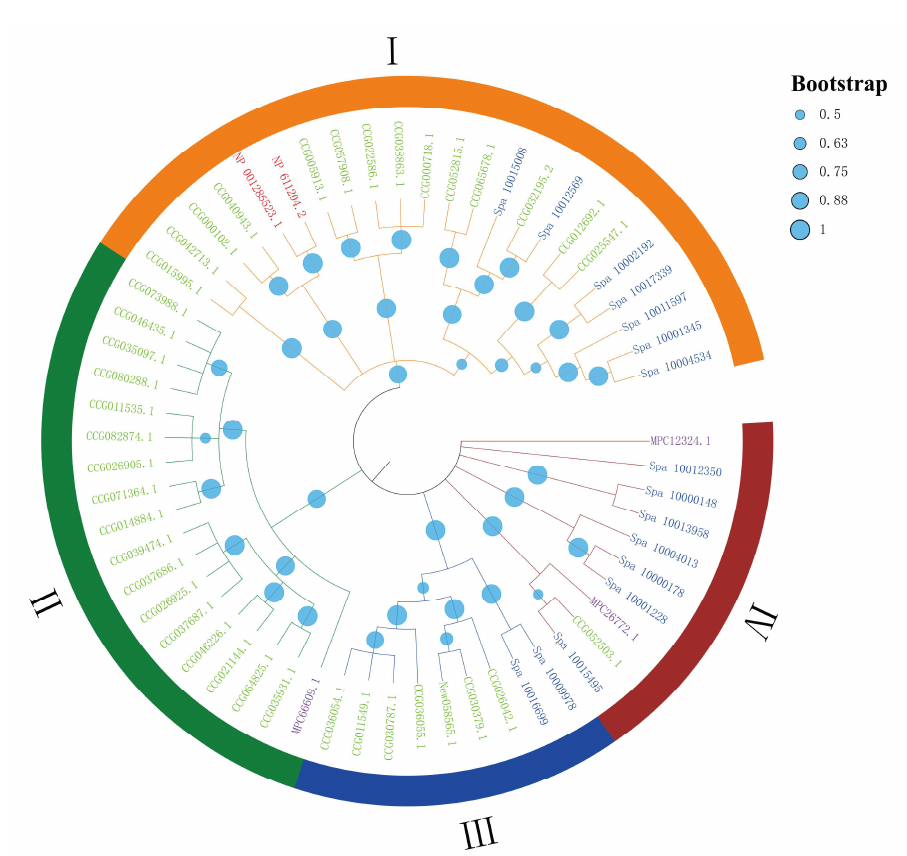
Figure 2. The phylogenetic tree of DDE_Tnp_4 family genes. Eriocheir sinensis , Scylla paramamosain , Portunus trituberculatus, and Daphnia pulex genes were distinguished by green, blue, purple, and red, respectively. Subfamily I, II, III, and IV were highlighted in orange, green, dark blue, and dark red, respectively.